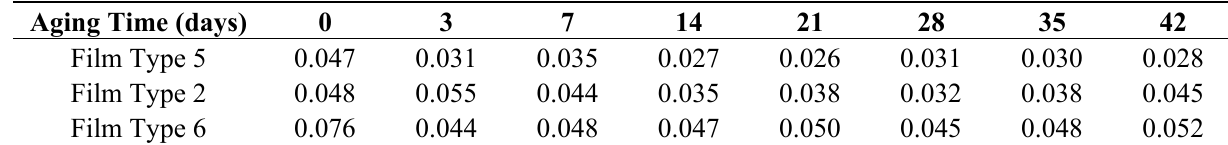
Table A6. Fracture strain vs. aging time at a 100 °C aging temperature for films with the same layer thickness, but various film thicknesses.